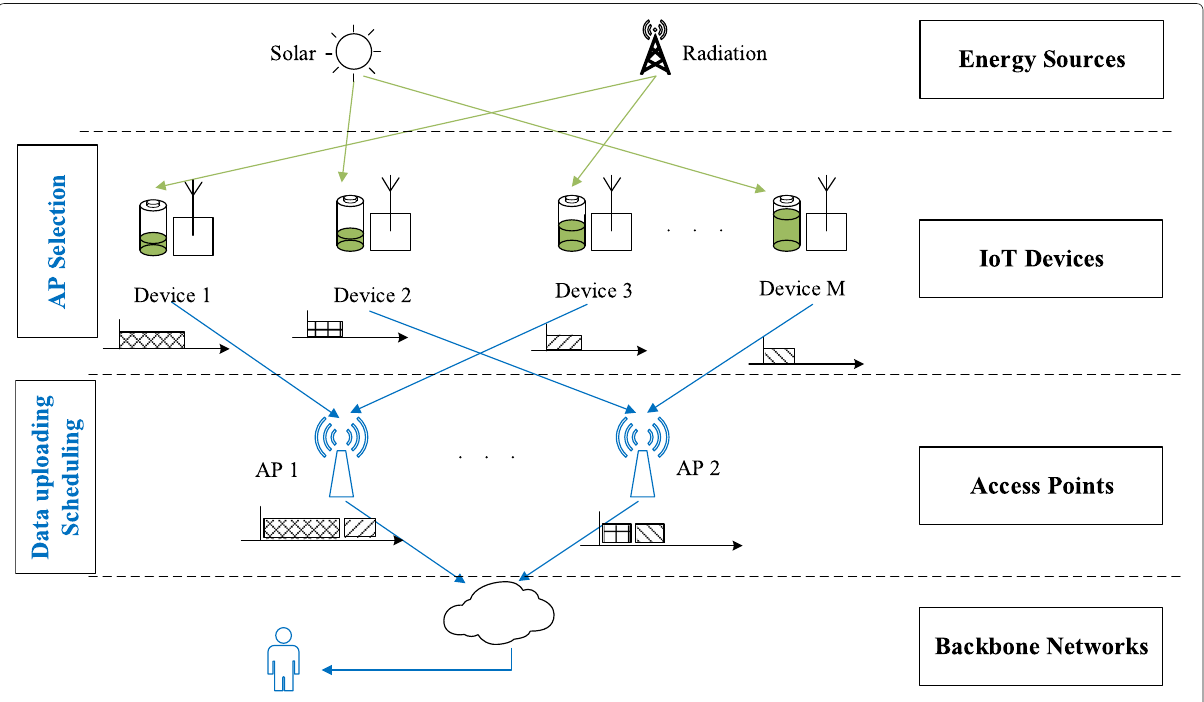
Fig. 1 System model. The figure describes the considered system model and the problems we are